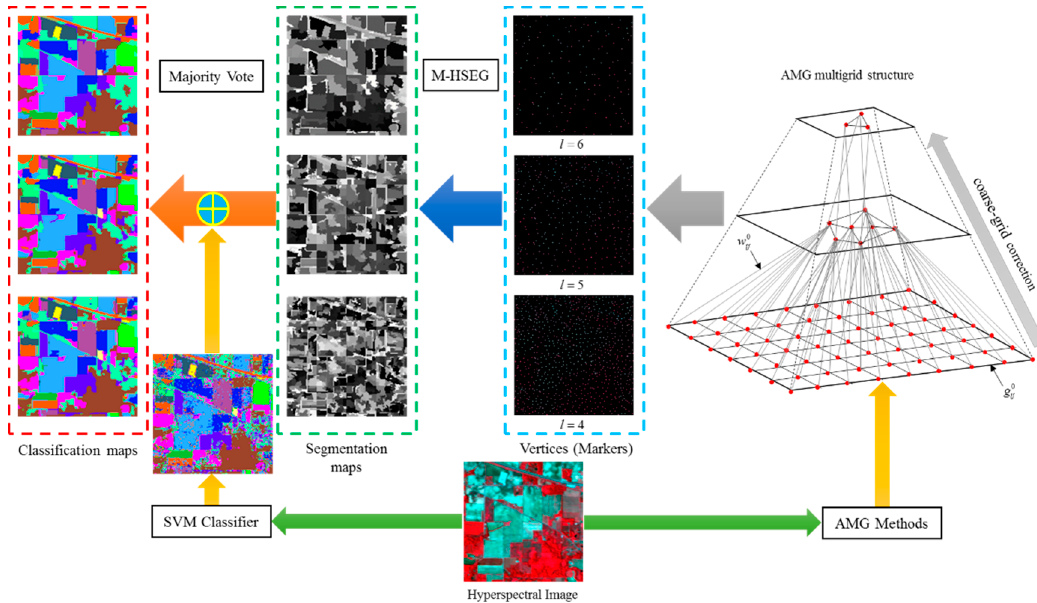
Figure 1. Spectral-spatial classification of hyperspectral images based on the AMG method and marker-based HSEG algorithm (M-HSEG). The original Indian Pines data set is visualized by an RGB composite of bands 47, 23, and 13; the marker maps are visualized by an RGB composite of bands 47, 23, and 13 using the representative spectra, which are used as the initial seeds (markers) for the HSEG algorithm. The segmentation maps correspond to the marker maps, and the different grey levels represent different region labels.